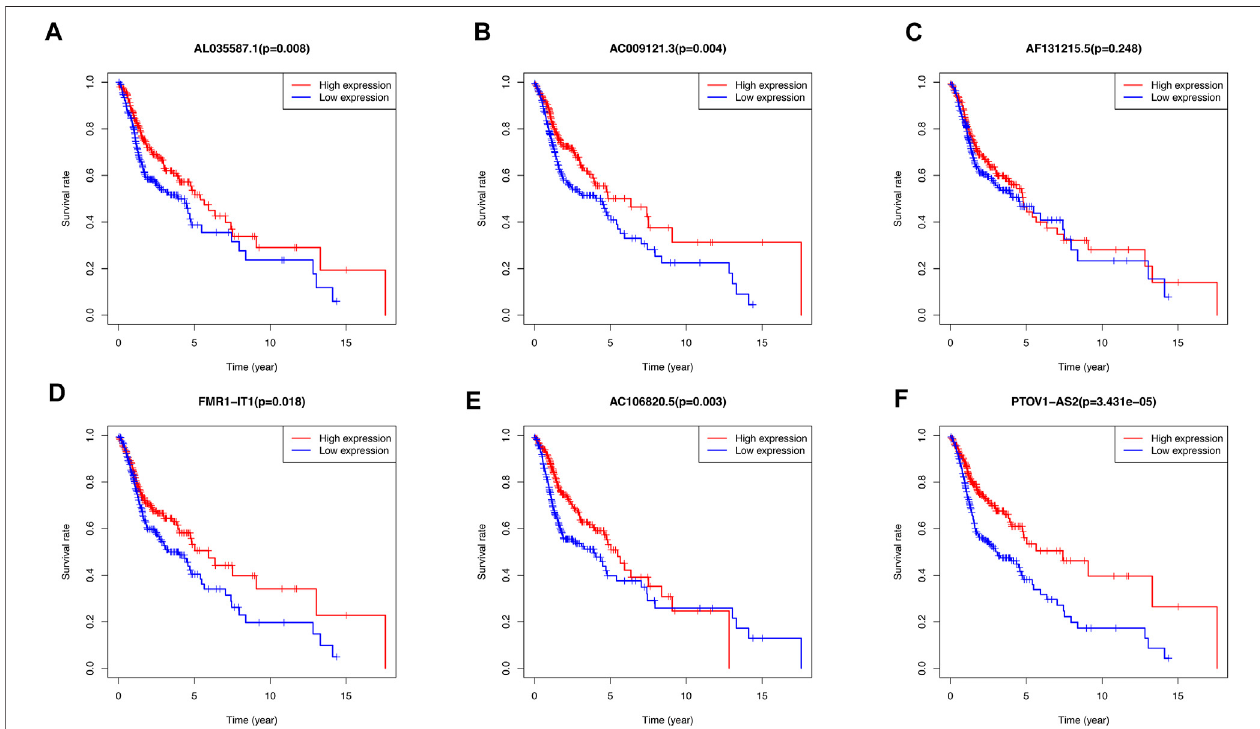
FIGURE 8 | Kaplan-Meier curves of overall survival for differential expression level of 6 m 6 A/m 5 C/m 1 A-related lncRNAsPrognostic signatures respectively. (A) The associationofAL035587.1 expression level withpatients ’ prognosisofTCGA database. (B) TheassociationofAC009121.3 expression level withpatients ’ prognosisof TCGAdatabase. (C) TheassociationofAF131215.5expressionlevelwithpatients ’ prognosisofTCGAdatabase. (D) TheassociationofFMR1-IT1expressionlevelwith patients ’ prognosis of TCGA database. (E) The association of AC106820.5 expression level with patients ’ prognosis of TCGA database. (F) The association of PTOV1-AS2 expression level with patients ’ prognosis of TCGA